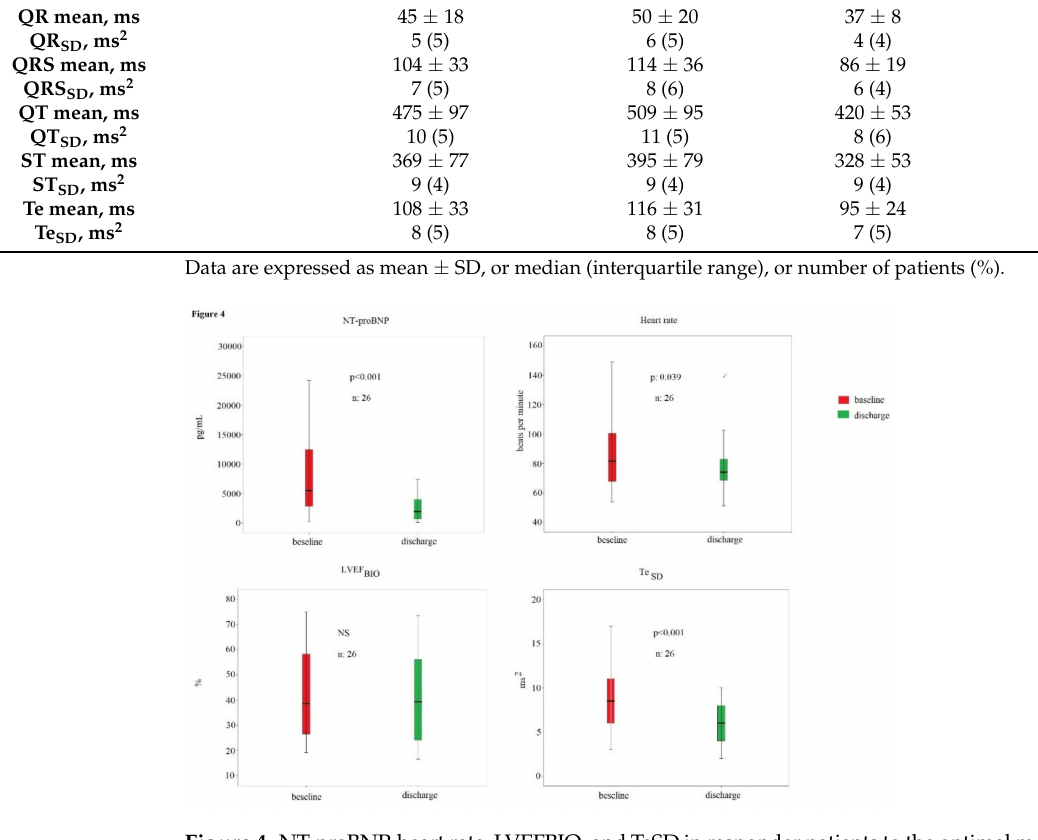
Figure 4. NT-proBNP, heart rate, LVEFBIO, and TeSD in responder patients to the optimal medical